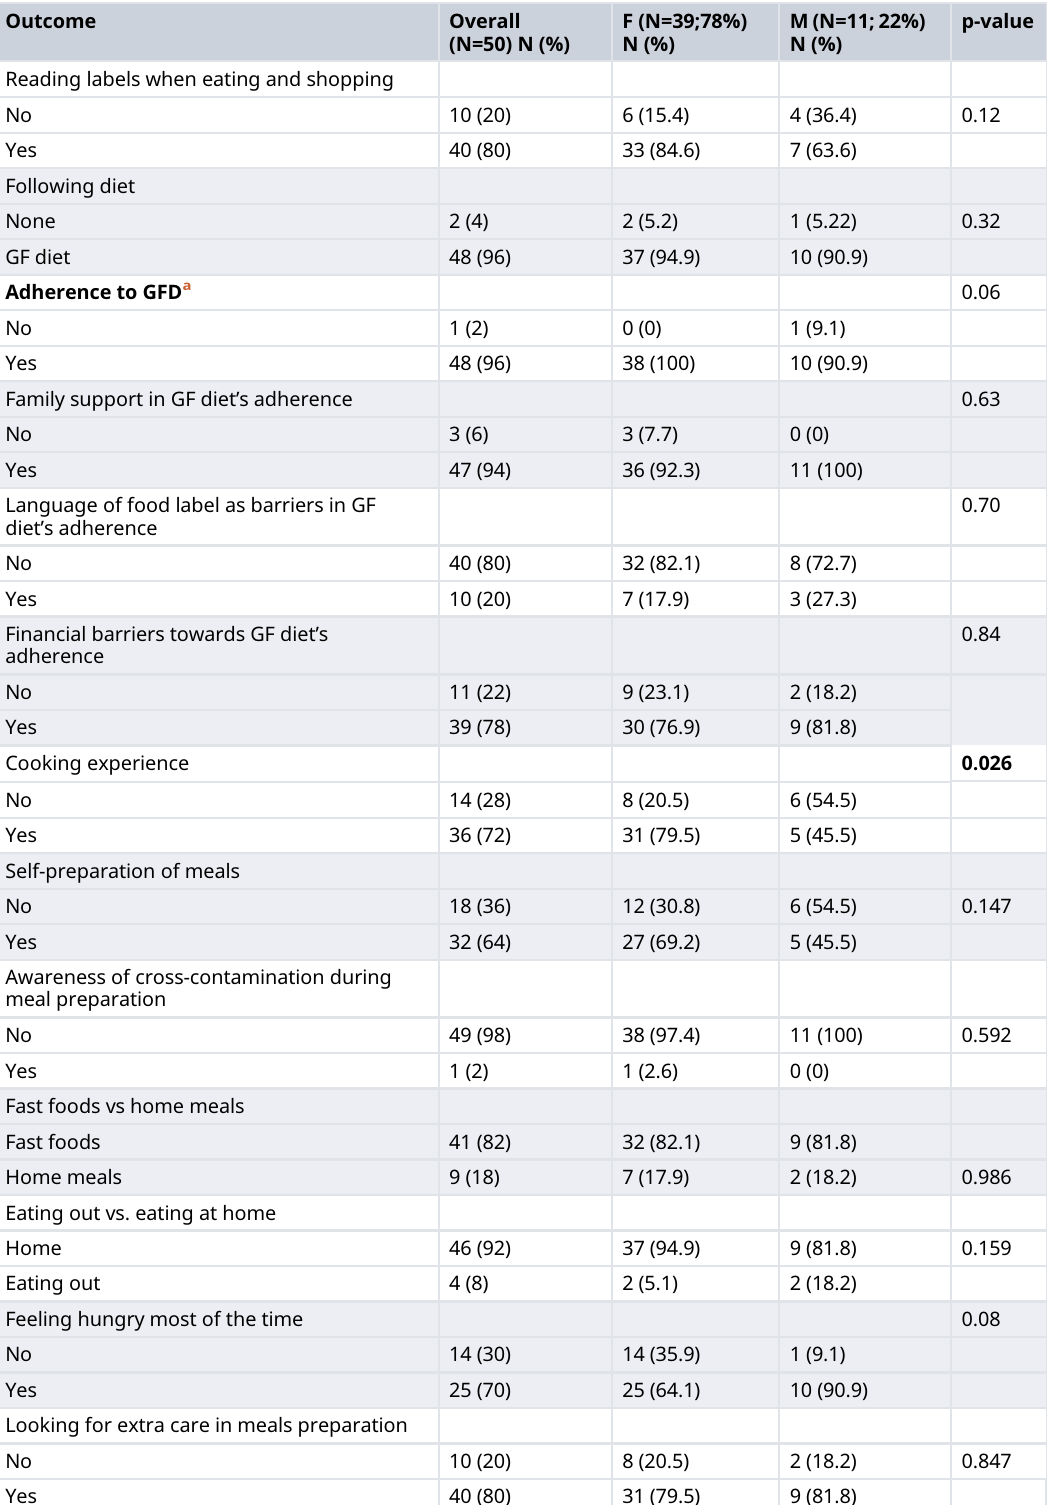
F (N=39;78%) M (N=11; 22%) (N=50) N (%) N (%) N (%)